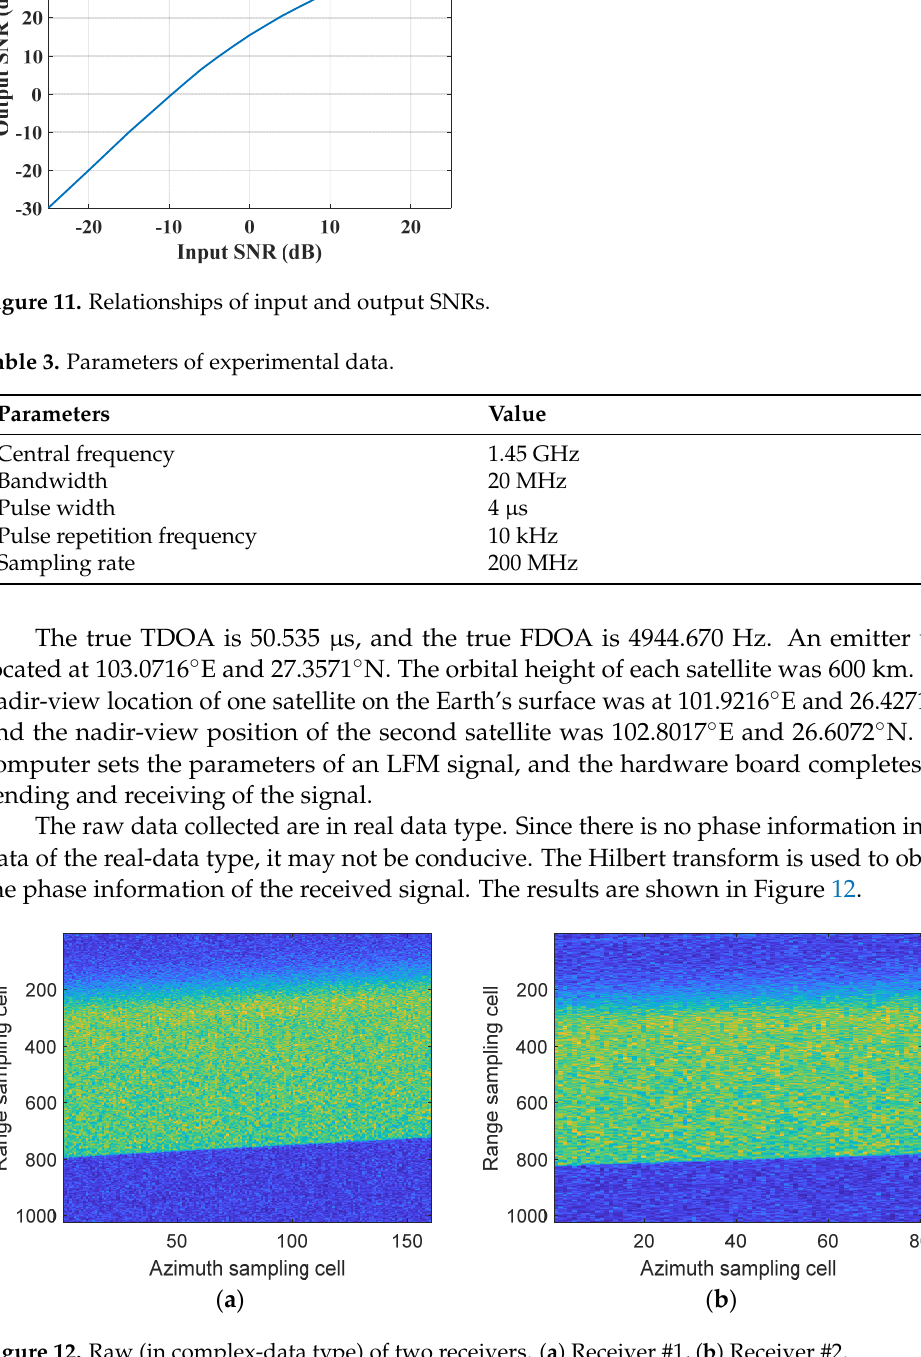
( b ) Figure 10. RMSEs of five methods. ( a ) RMSE of the TDOA estimation, ( b ) RMSE of the FDOA esti- mation. As the reference pulse by the parameter-based method does not contain noise, its overall performance of the TDOA and FDOA estimations is better than that of the raw data-based method. However, the raw data-based method can still be viable since an emit- ter’s system parameters are typically unknown. Thus, it is valuable that the applicability of the raw data-based method is articulated further, with the consideration of the input and output SNRs. Assuming that size of the raw data was mn , and the compressed data size was m ′ n ′ . If the SNR for the input is SNR in , the output SNR, SNR out is